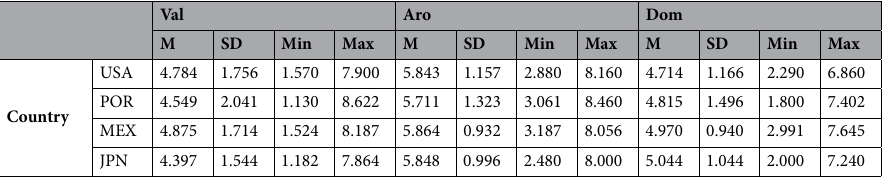
Table 1. Descriptive statistics for each dimension and country. Val valence, Aro arousal, Dom dominance.